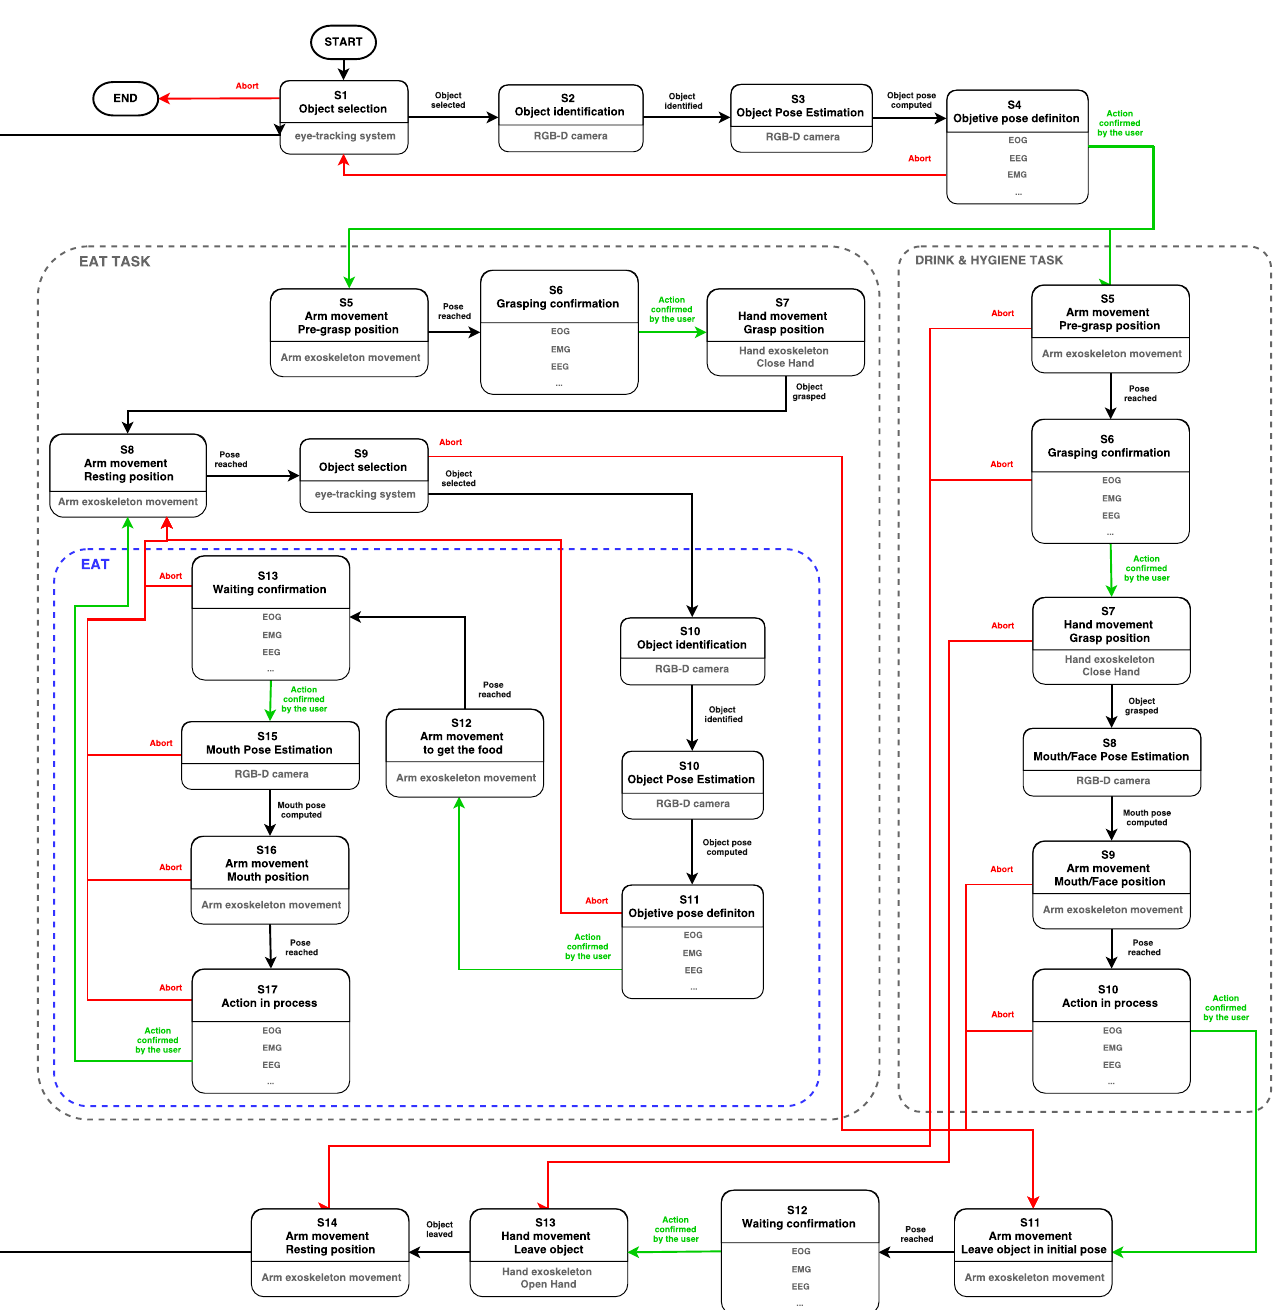
Figure 5. Finite state machine (FSM) for the eating, drinking, and hygiene tasks. They are are sequential implemented allowing the user to continue or abort the task in anytime. Black arrows refer to automatic processes. Green arrow refer to an action confirmed by the user, and the red arrows refer to the decision to abort the current activity by the